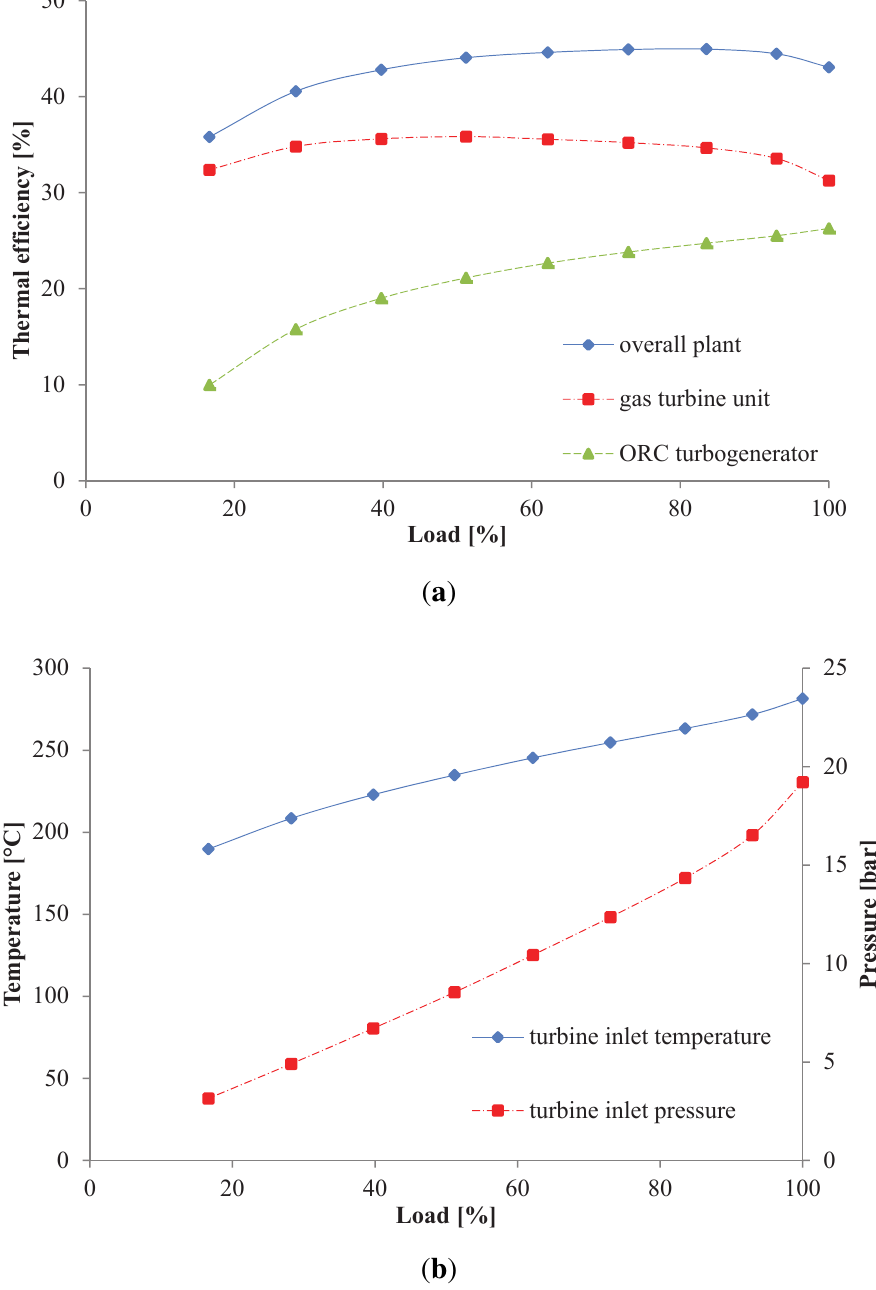
Figure 6. Results of the part-load analysis: ( a ) thermal efficiency of the plant, gas turbine module and ORC unit as a function of the load; and ( b ) temperature and pressure at the inlet of the ORC expander as a function of the